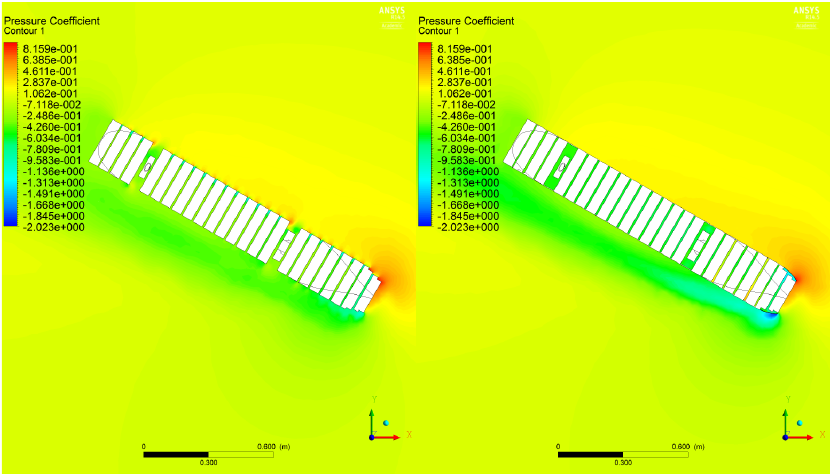
Figure 28. Pressure distributions around the container ship with (Right) and without (Left) side covers in oblique winds at z = 0.12 m, ψ = 30 deg.